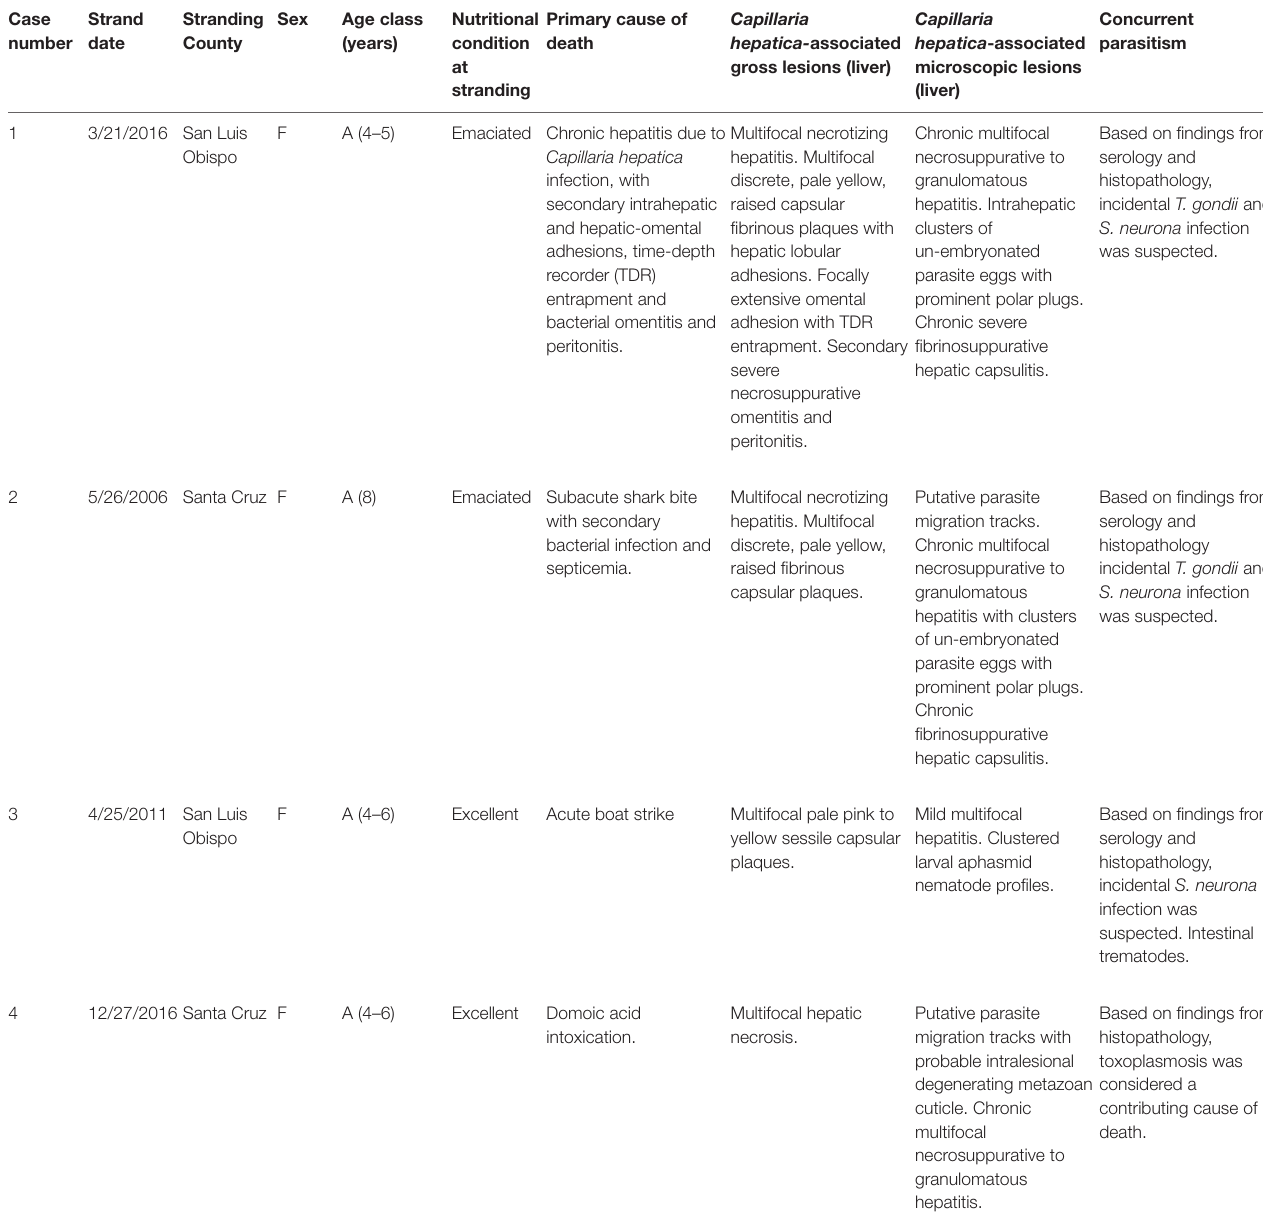
TABLE 1 | Summary of stranding data, gross findings and histopathology for southern sea otters ( Enhydra lutris nereis ) with putative or confirmed Capillaria hepatica